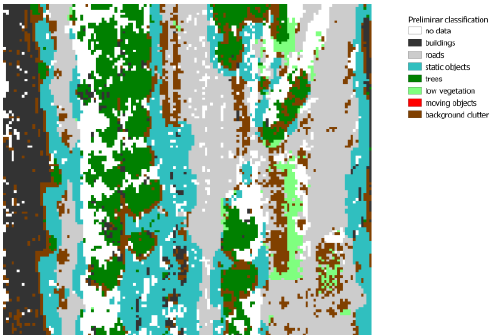
Figure 9 . Preliminary segmentation of the static scenario.